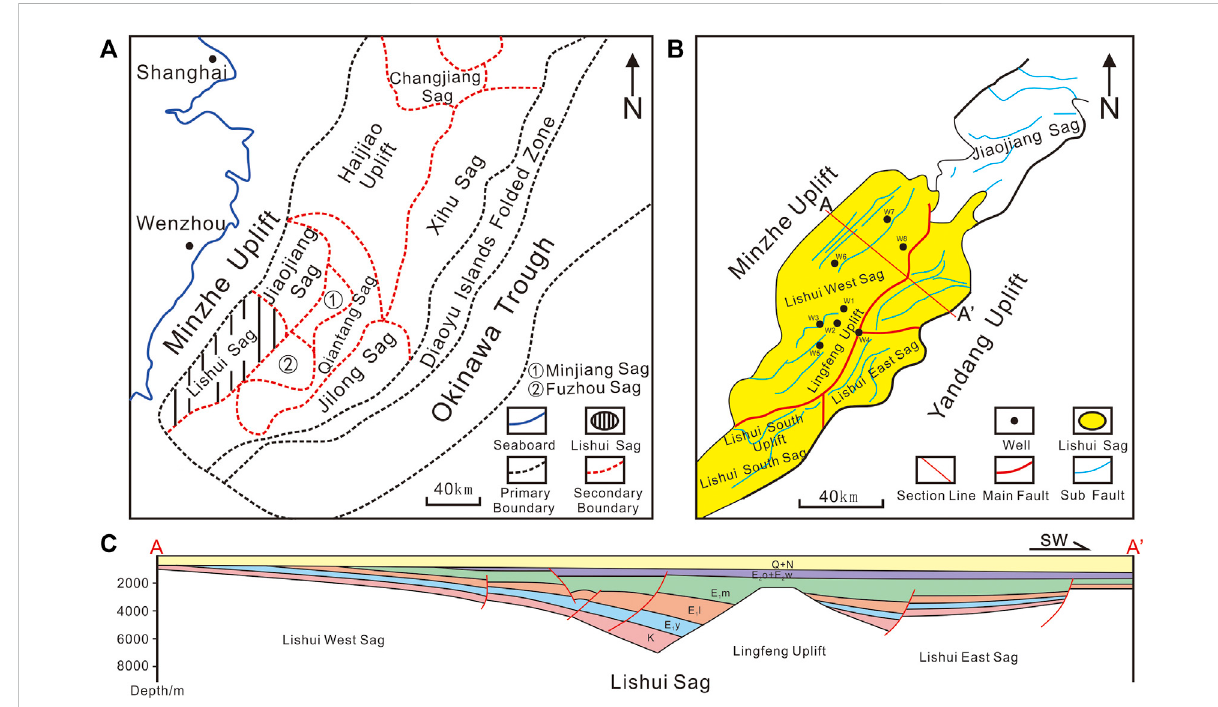
FIGURE 1 Regional geologic setting of the Lishui Sag. (A) The Lishui Sag, located in the west – south part of the East China Sea Basin, on the west of the YandangUplift,eastoftheMinzheUplift,andsouthoftheJiaojiangSag. (B) LishuiSag,containing fi vetectonicunits.Theextensioncausesaseriesof NE- to NNE-striking normal faults in this area. (C) Geological section, showing the basic tectonic features in the Lishui Sag.